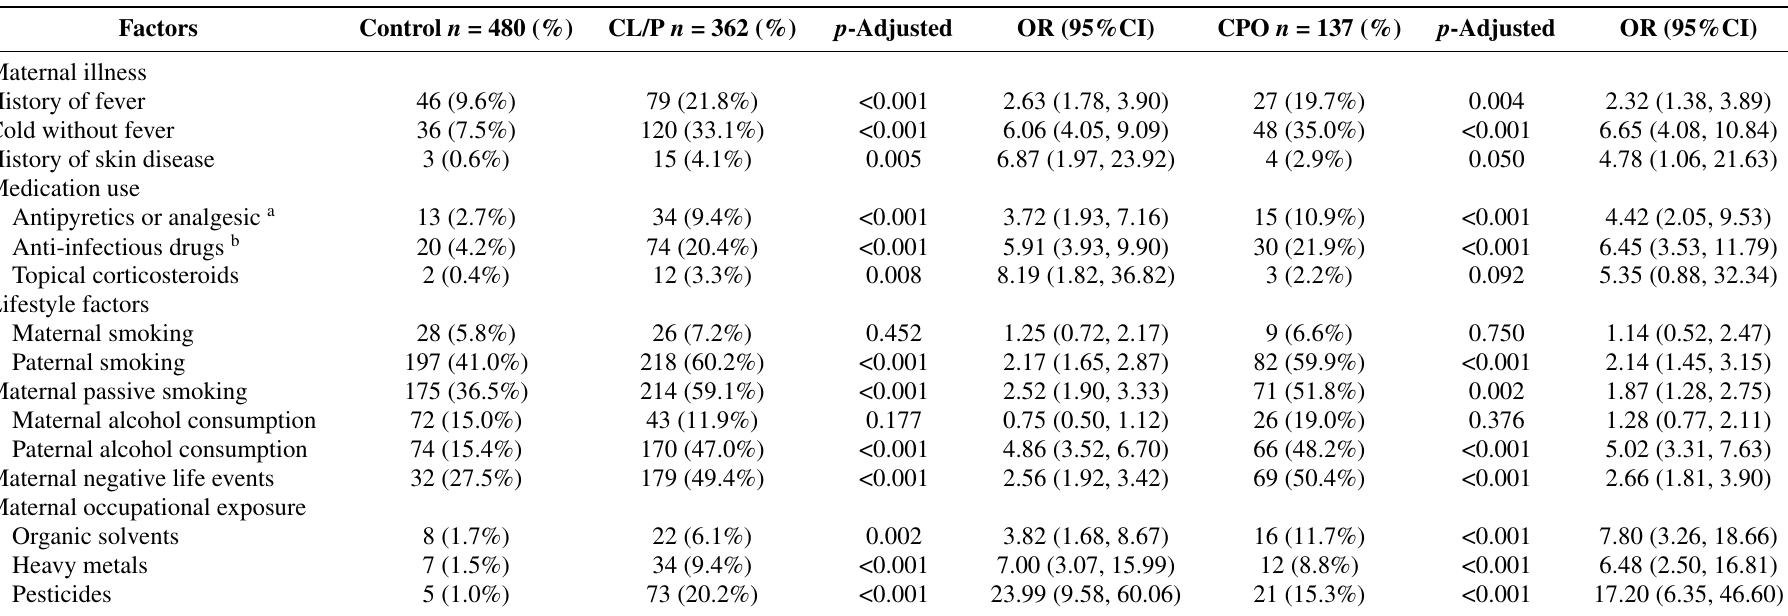
Table 2. Maternal health factors, occupational exposures, and parental lifestyle factors of cases and controls during the first